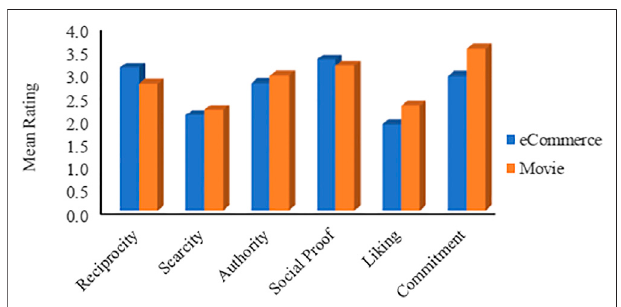
FIGURE 6 | Mean rating based on the application